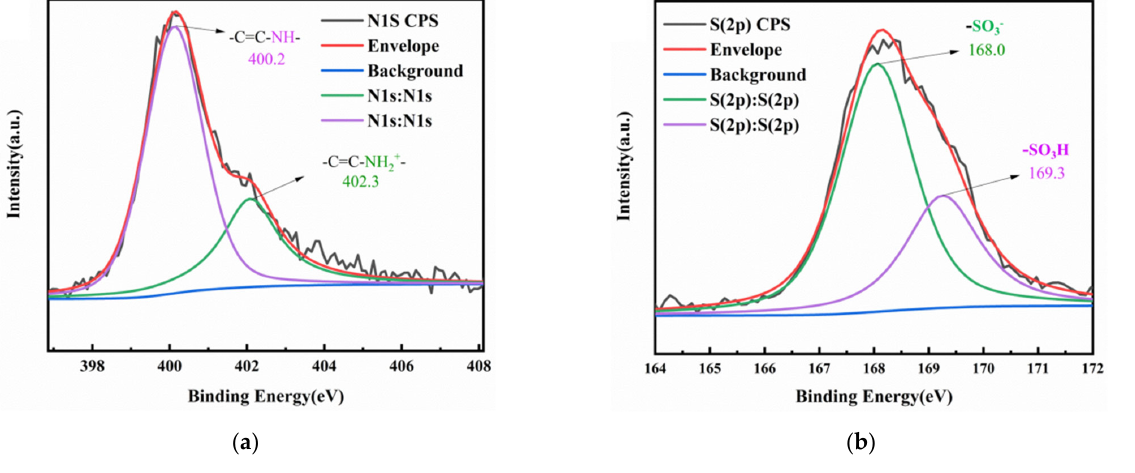
Figure 3. XPS spectra of the PAN/TpPa ‐ SO 3 H nanofibers. Binding energy of ( a ) N1s and ( b ) S2p for TpPa ‐ SO 3 H.